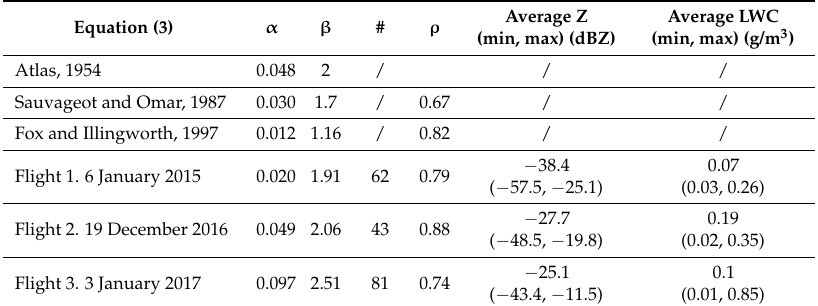
Table 3. Parametrical coefficient to optimize Equation (3) with Z measured with cloud radar and LWC measured by LOAC sensor along the tethered balloon flight.